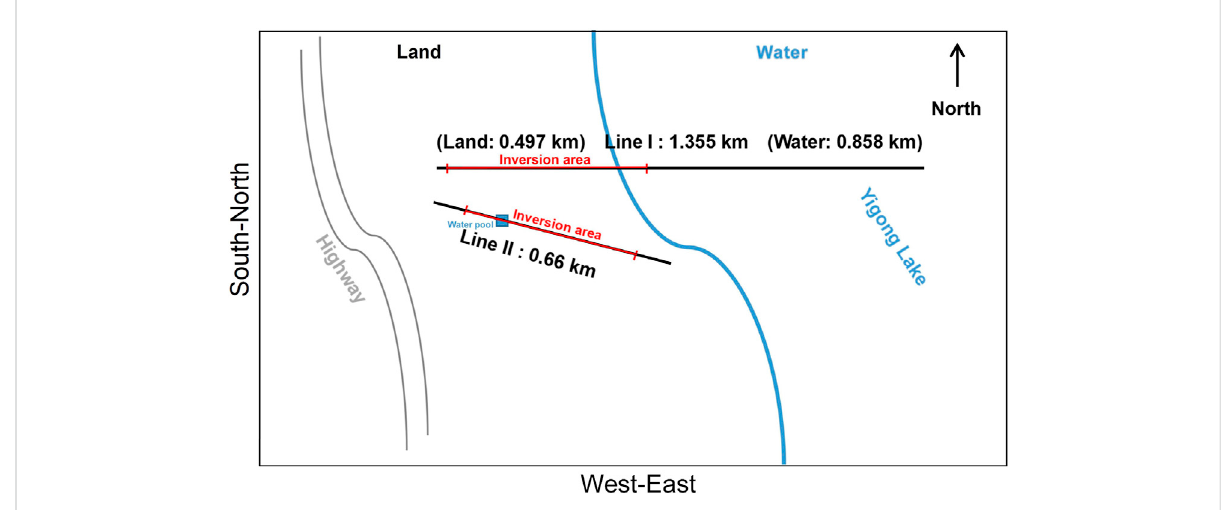
FIGURE 2 Schematic layout of the trenched optical fi ber